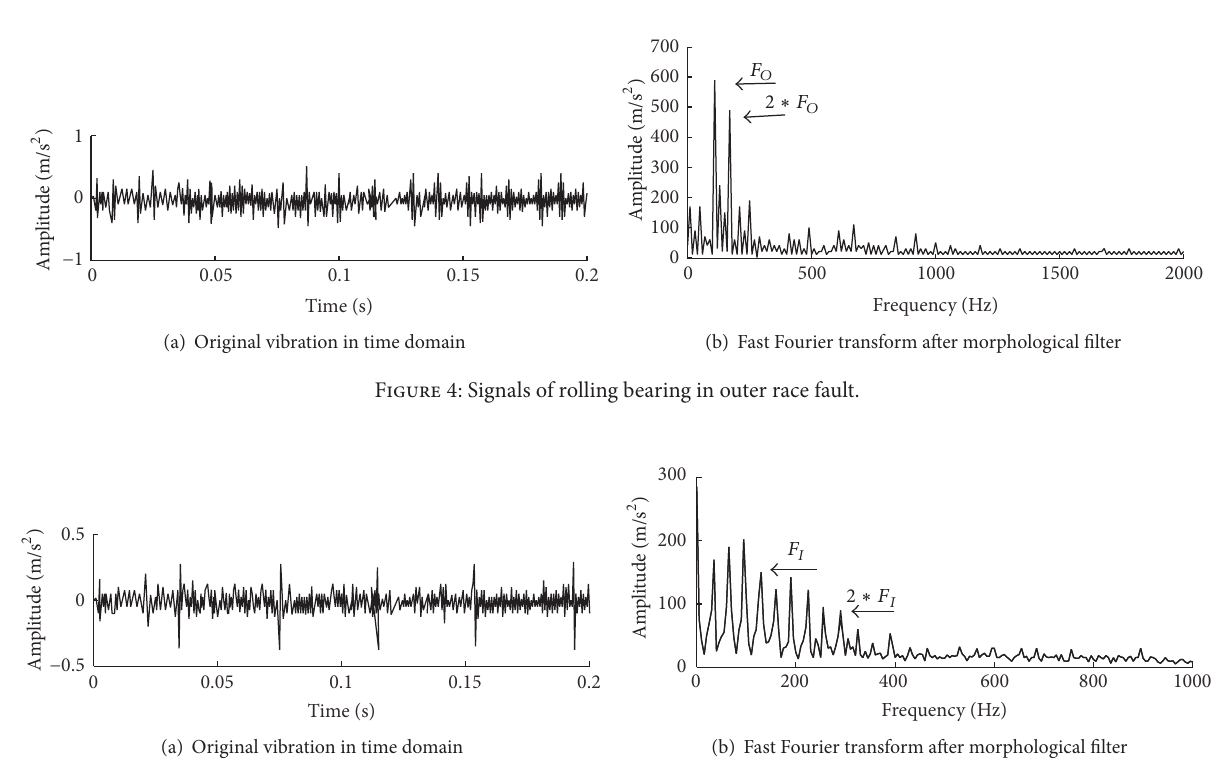
Figure 5: Signals of rolling bearing in inner race fault.